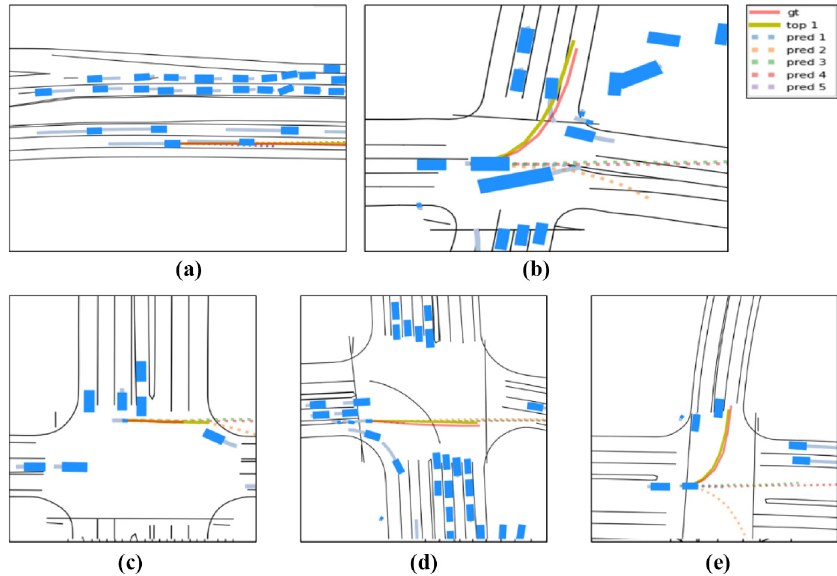
Figure 4 Trajectories generated by social-lane aggregator